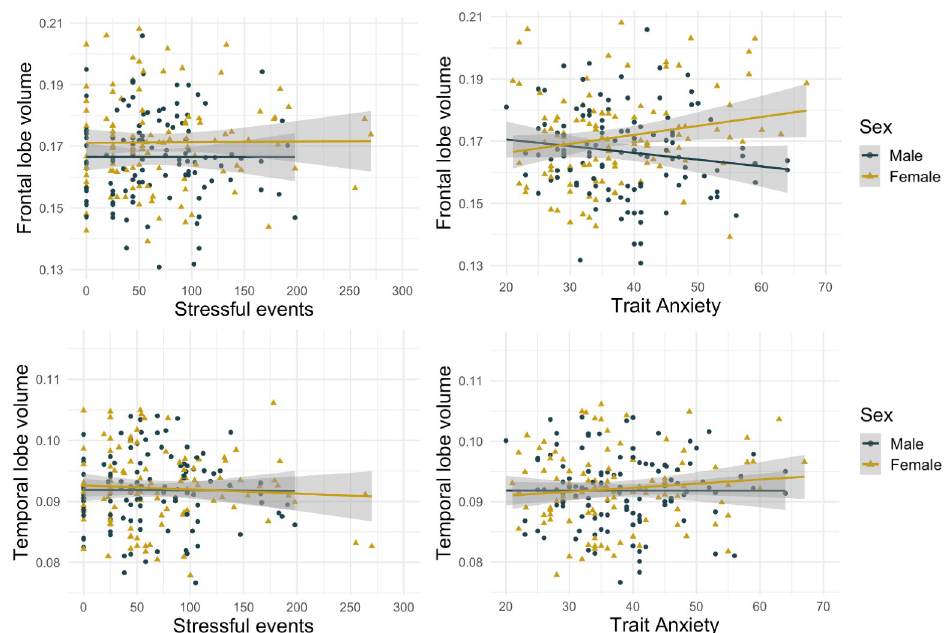
Fig 1. Scatterplots for correlations between maternal trait anxiety/stress and volumes for the frontal and temporal lobes. See Fig A in S1 File for partial regression scatterplots. events (B = .0000027, t = .495, p = .621) or trait anxiety (B = .0000047, t = .140, p = .889)